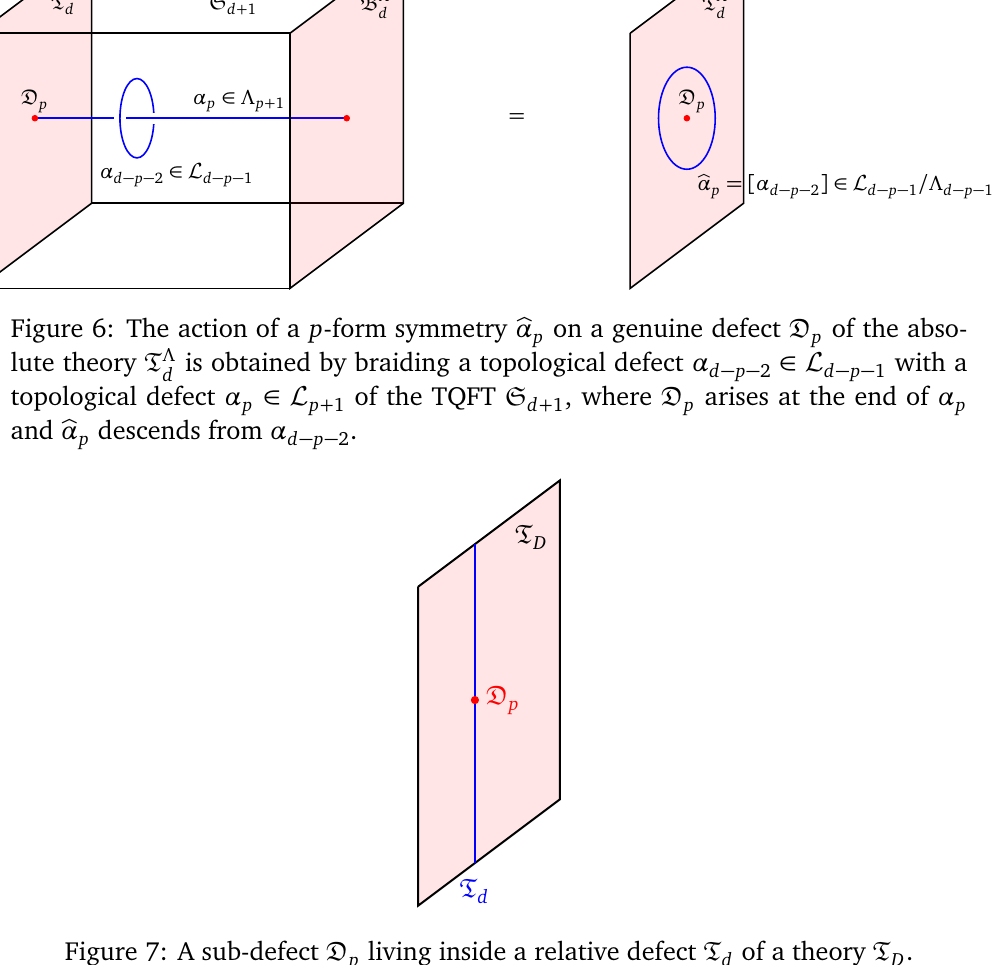
living inside a relative defect T p